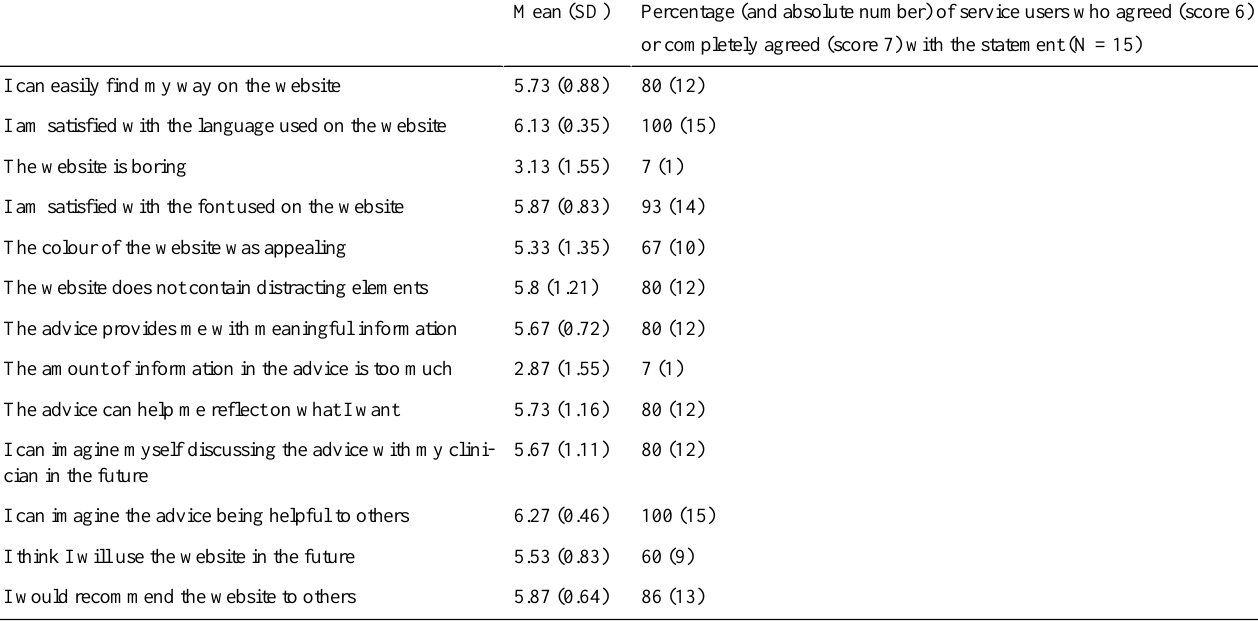
Table 3. Results of Satisfaction Questionnaire